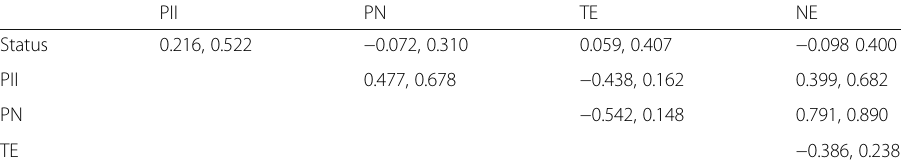
Table 6 Measuring similarity between pairs of centrality indices from Table 5. In each cell, the first value is Kendall rank correlation coefficient and the second value is RBO similarity value. TE and NE stand for total effect and net effect as derived from our new methodology PII PN